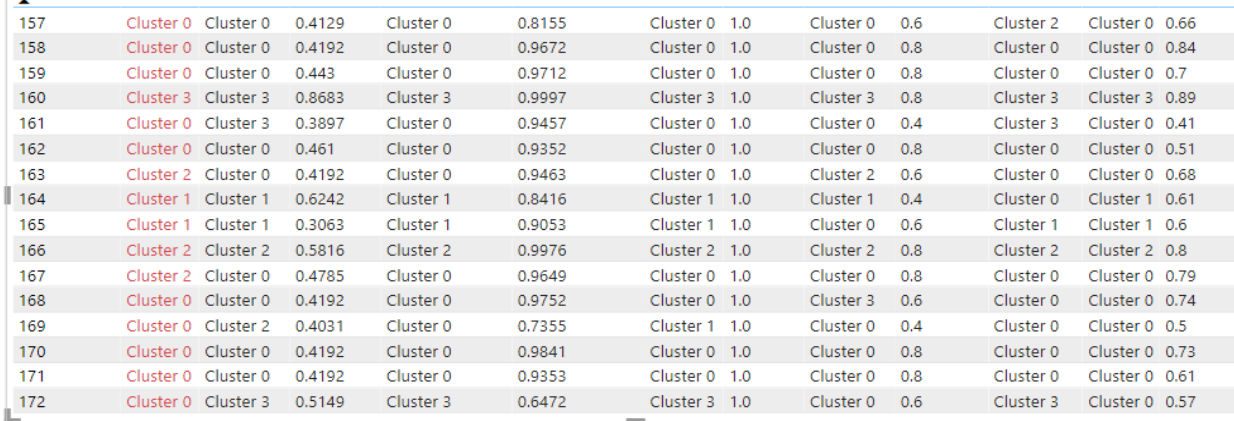
Figure 10. O44. Results of the testing process.